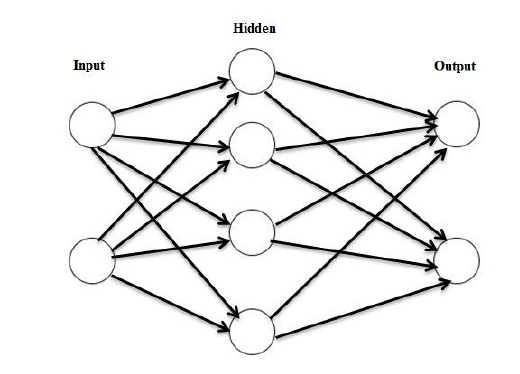
Our training algorithm is Levenberg-Marquardt (Levenberg, 1944; Marquardt, 1963; Moré, 1978; Lourakis, 2005). Levenberg-Marquardt algorithm is an iterative technique